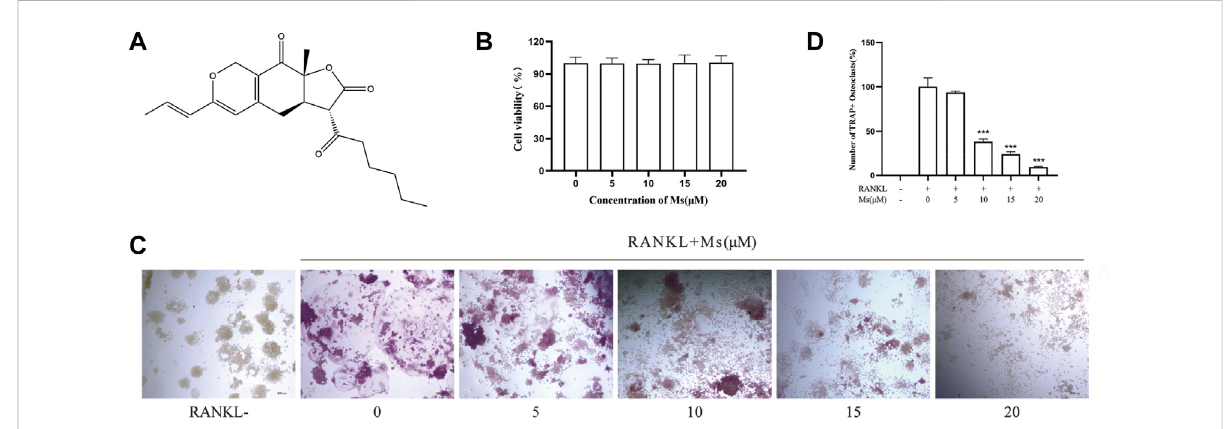
FIGURE 1 Inhibitory effect of Ms on RANKL-induced osteoclast formation in vitro . (A) Chemical structure of Ms. (B) Viability of RAW264.7 cells. RAW264.7 cells exposed to 5, 10, 15 and 20 μ M Ms were assessed by CCK-8 kits after 72 h. (C) The osteoclast morphology after incubation with RANKL and Ms at 5, 10, 15 and 20 μ M for 5 days. TRAP-positive cells (TRAP (+)) (nuclei ≥ 3) were photographed by a light microscope, original magni fi cation ×200 (Scale bar = 200 μ m). (D) Quantitative assessment of TRAP-positive cells. The results represent the mean ± SD of